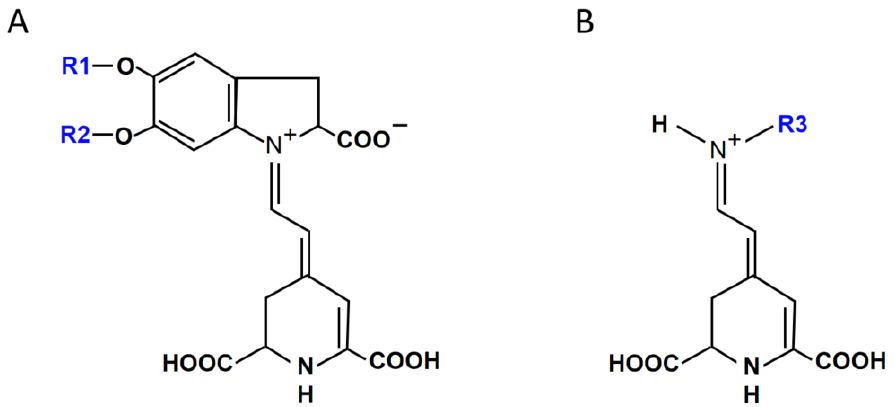
Figure 1. Structure of betacyanins (Bc) ( A ) and betaxanthins (Bx) ( B ). R1 and R2: hydrogen or sugar moieties; R3: amino acid or amine group. After [9,12], modified.